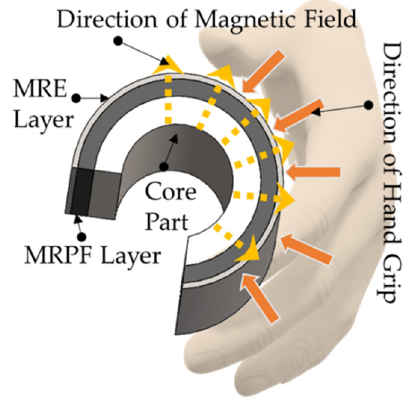
Figure 3. The structural configuration of the proposed MRTGC.